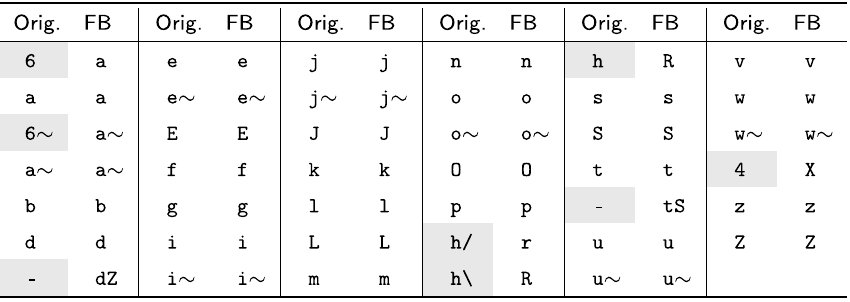
Table 6 Equivalence table between phonemes present in the hand-aligned dataset (original) and the ones yielded by FalaBrasil’s G2P tool